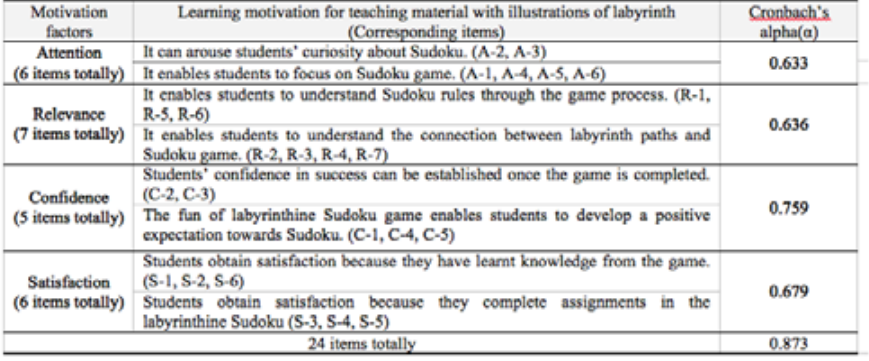
Relationship between ARCS motivation factors and labyrinth Sudoku (source: compiled by this